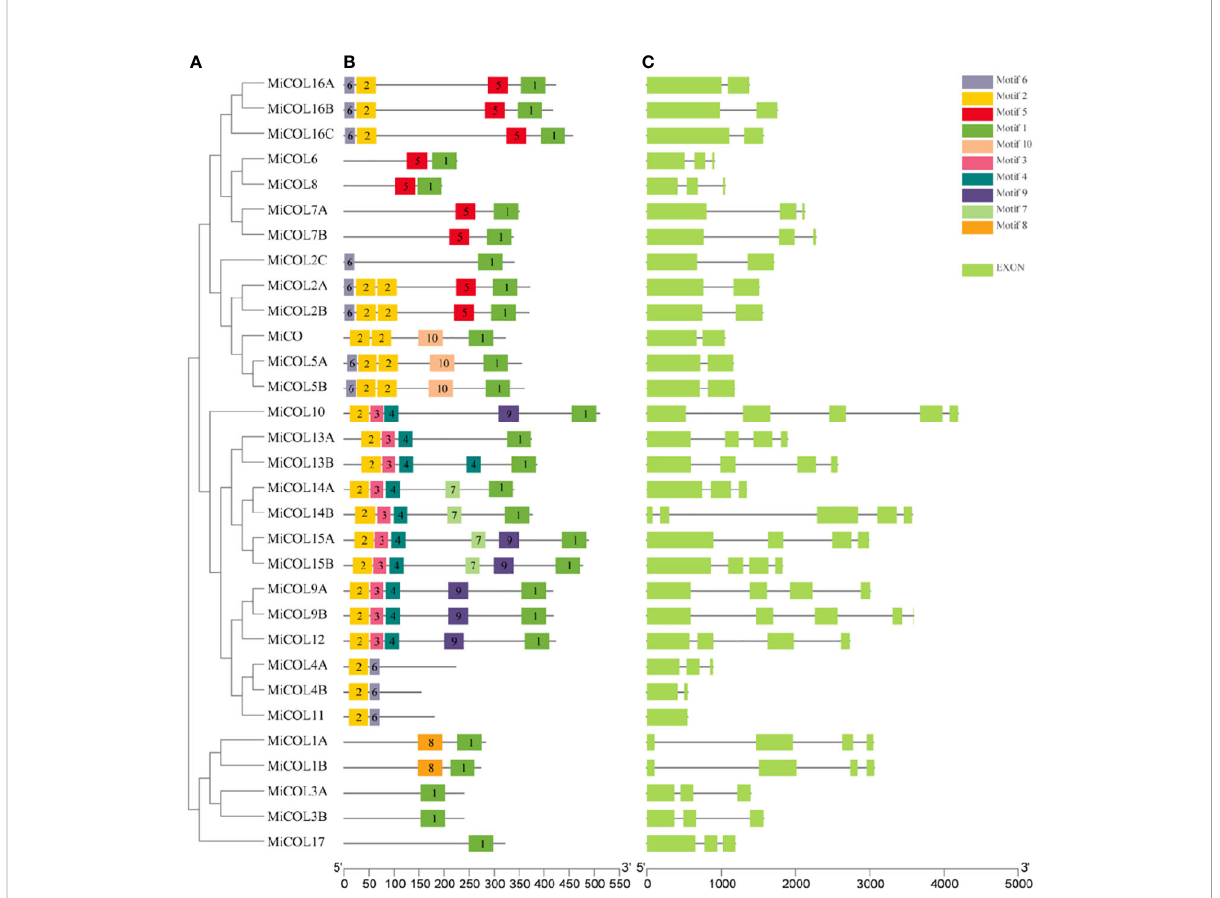
FIGURE 2 Phylogenetic, conserved motif, intron and exon structure analysis of the MiCOL genes in mango. (A) Phylogenetic analysis. (B) Conserved motif analysis. Different patterns are represented by different colors. (C) Gene structures. Exons and introns are represented by green rectangles and black lines,